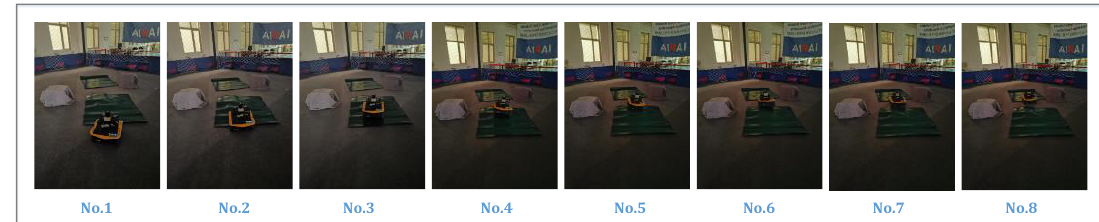
Figure 19. Experiment at different times.